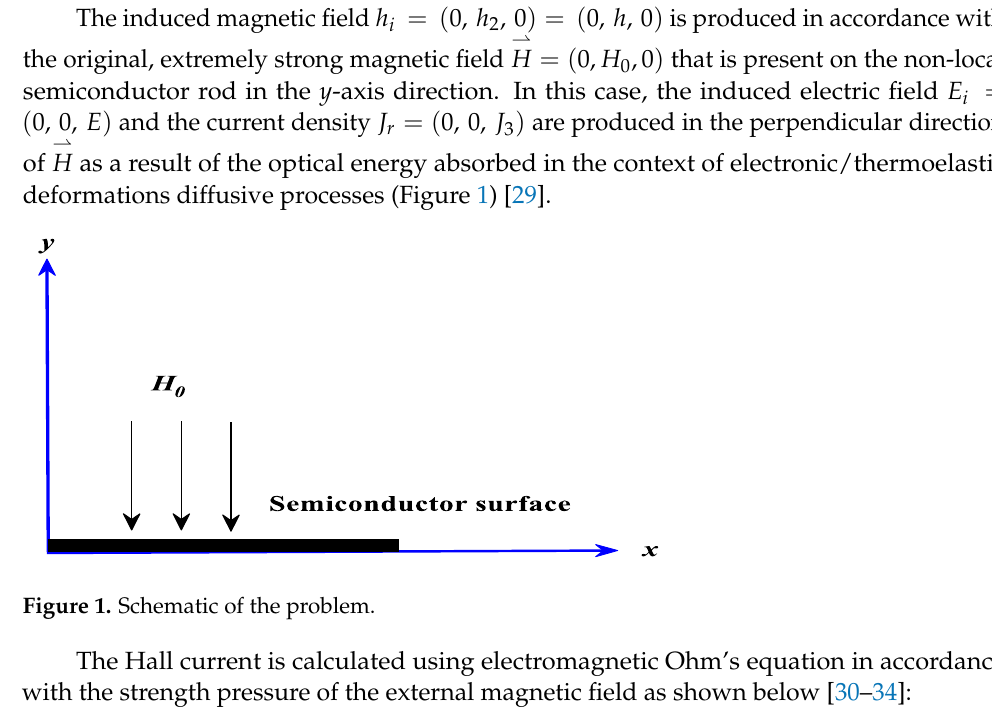
Figure 1. Schematic of the problem.